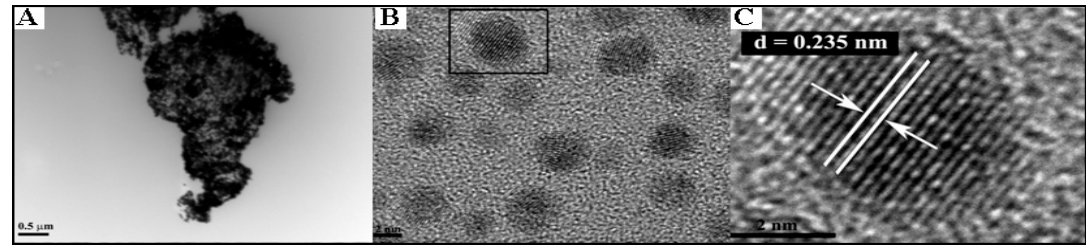
Figure 7. ( A ) TEM, ( B ) and ( C ) HRTEM images of GO-PFcMAss-AuNPs